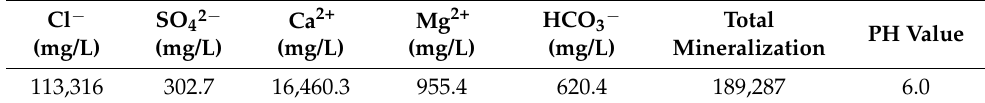
Table 2. Composition of the formation water.